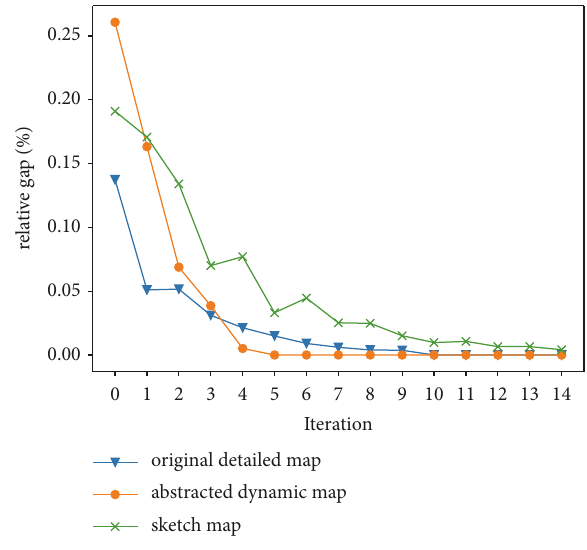
Figure 14: Convergence